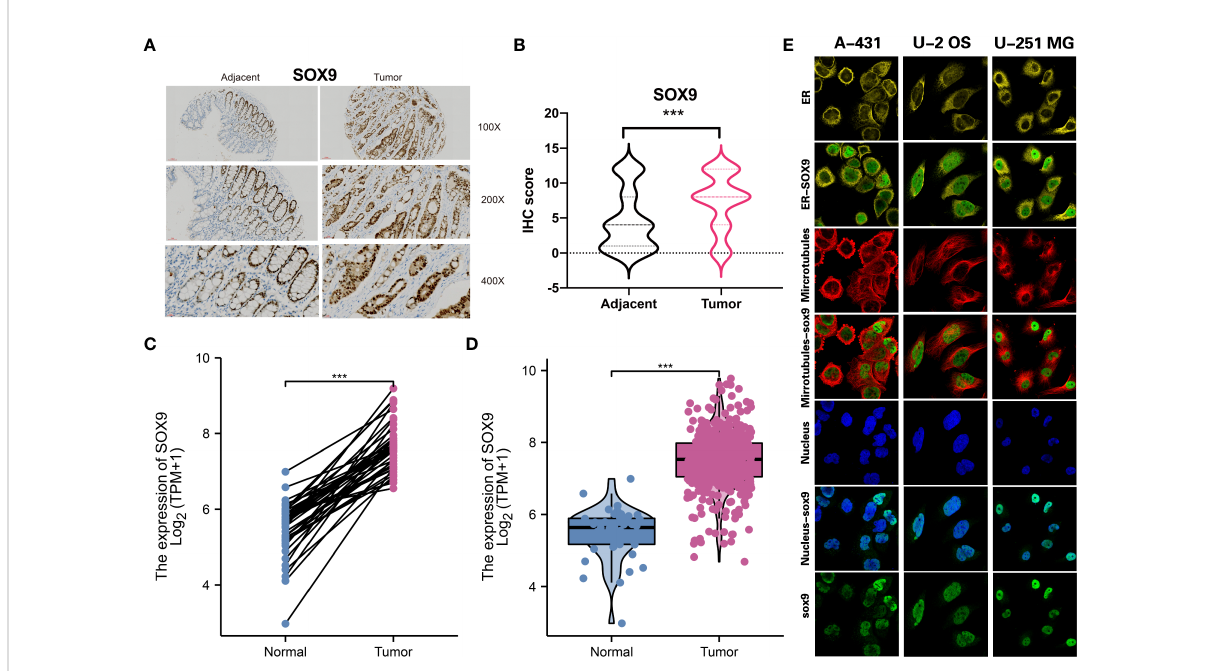
FIGURE 8 Molecular subtype biomarkers validated by wet experiment. (A) SOX9 protein expression of the represent sample in adjacent and tumor samples by IHC. (B) Pair-test for SOX9 protein expression between 50 tumor tissue and 50 tumor adjacent tissue by IHC. (C) and (D) SOX9 gene expression between tumor tissue and adjacent tissue in TCGA-COAD public cohort. (E) The location of SOX9 in A-431, U-2 OS and U-251 MG in the Human Protein Atlas(HPA).